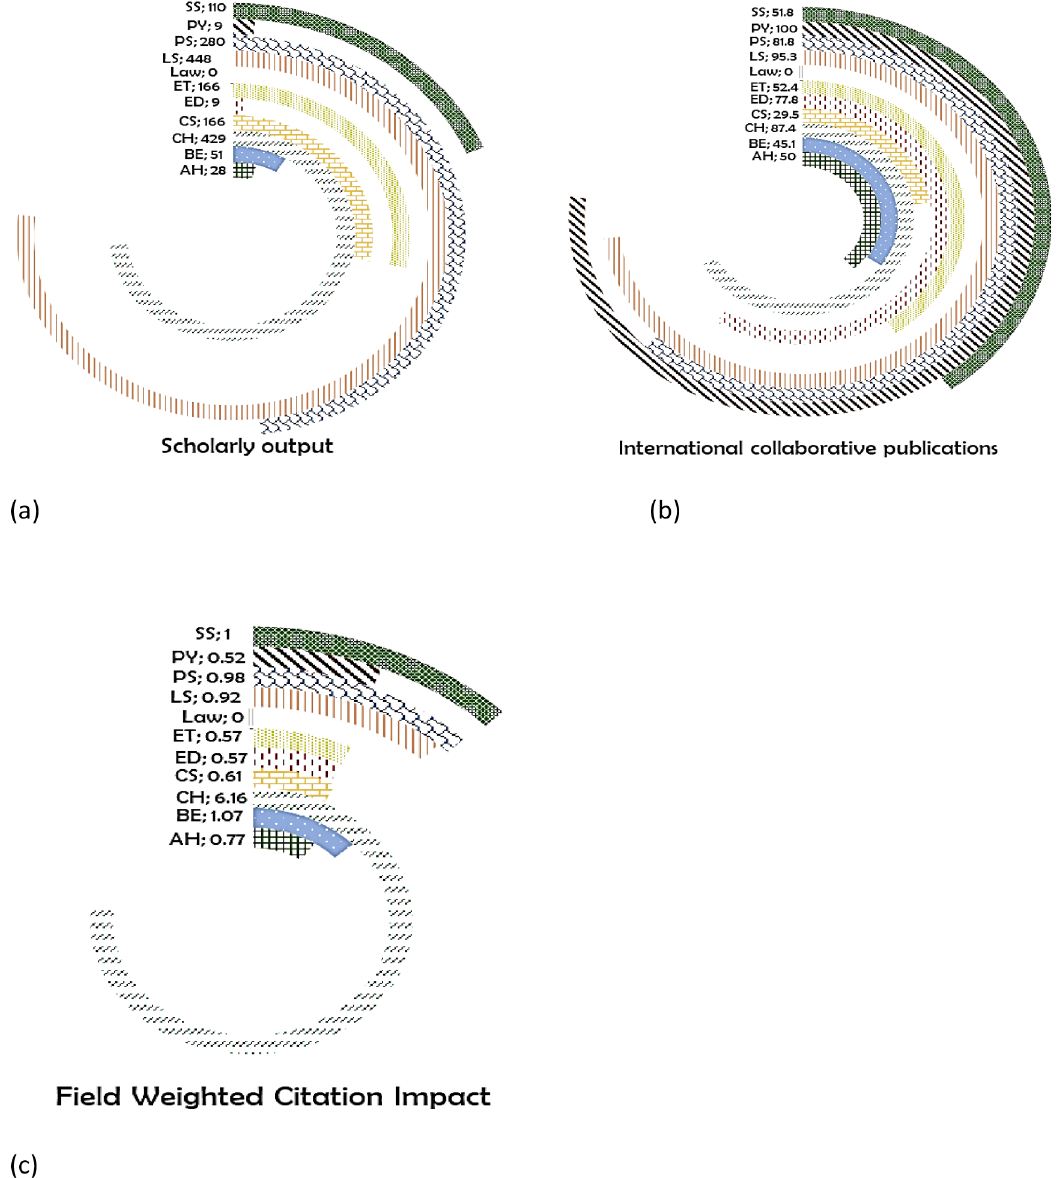
Figure 12. Subject wise split of Myanmar research outcome (a) scholarly output, (b) International collabora- tion and (c) FWCI. Arts & Humanities (AH), Business and Economics (BE), Clinical, pre-clinical and health (CH), Computer Science (CS), Education (ED), Engineering and Technology (ET), Life Science (LS), Physical Science (PS), Psychology (PY), Social Science